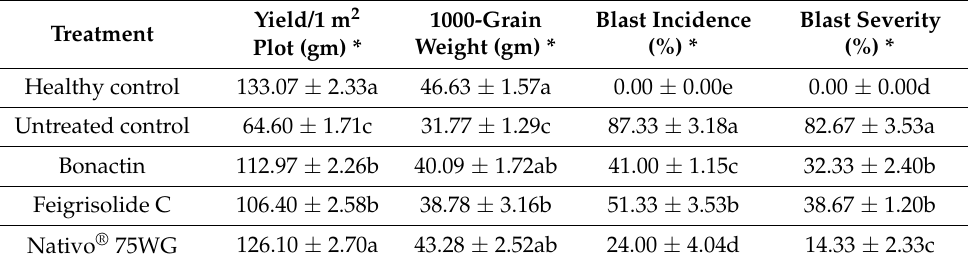
Figure 6. Inhibition of wheat blast disease with bonactin, feigrisolide C at 5 µg/mL, and Nativo ® 75WG at 50 µg/mL; ( a ) Uninoculated, untreated spike, ( b ) BTJP 4 (5) inoculation + water control + ( c ) bonactin + BTJP 4 (5) inoculation, ( d ) feigrisolide C + BTJP 4 (5) inoculation, ( e ) Nativo ® 75WG + BTJP 4 (5) inoculation. Table 2. Effect of bonactin and feigrisolide C on wheat (variety-BARI Gom-26) yield and yield components in field conditions following the artificial inoculation with BTJP 4 (5).